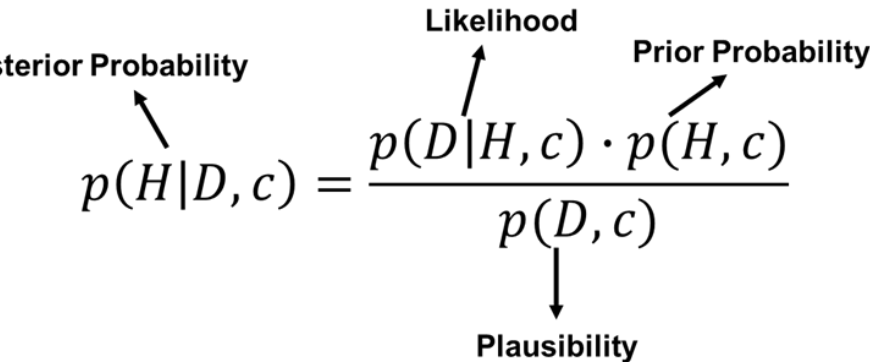
Figure 1. The Bayes’ formula: D represents the data we gather about a hypothesis H , whose probability we want to estimate, within the context c .